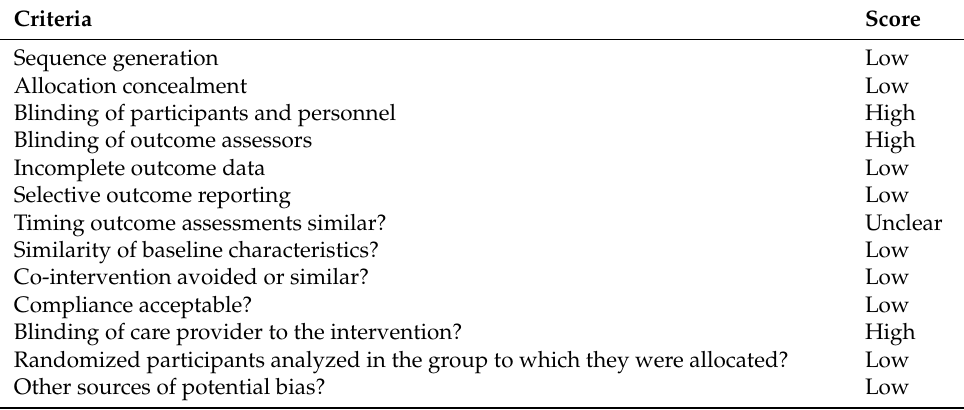
Table 2. Risk of bias assessment.